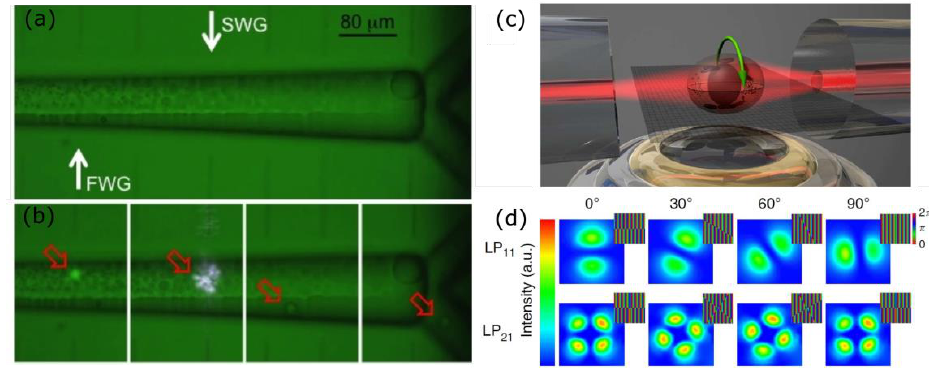
Figure 4. Panel ( a ) shows the microscope image of the integrated fluorescence activated cell sorter, presented by Bragheri et al. (reproduced from [97] with permission from the Royal Society of Chemistry). The waveguide used for fluorescence excitation (FWG) and the sorting waveguide (SWG) are highlighted by white arrows. The corresponding device validation is reported in panel ( b ). Panel ( c ) shows the scheme of an optical cell rotator, which using a non-rotationally symmetric beam is capable to rotate a particle. Panel ( d ) shows the different phase masks applied to the spatial light modulator and the corresponding supported mode at the fiber output. Changing the mask it is possible to rotate the mode and therefore the trapped specimen (reproduced with permission from [100]).